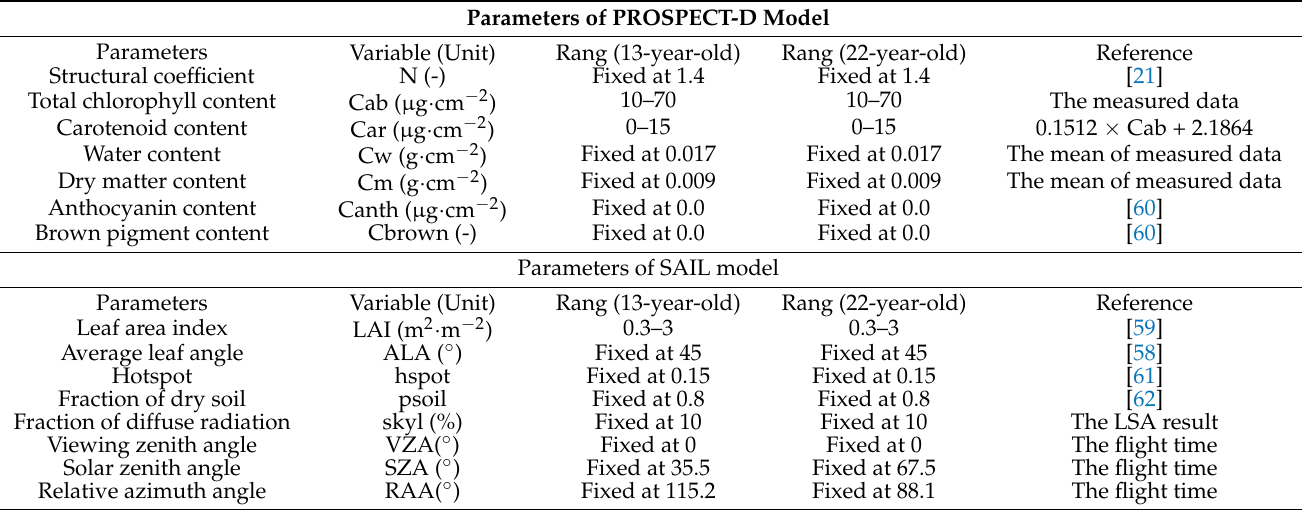
Table 3. Summary of values or ranges for each input parameter of